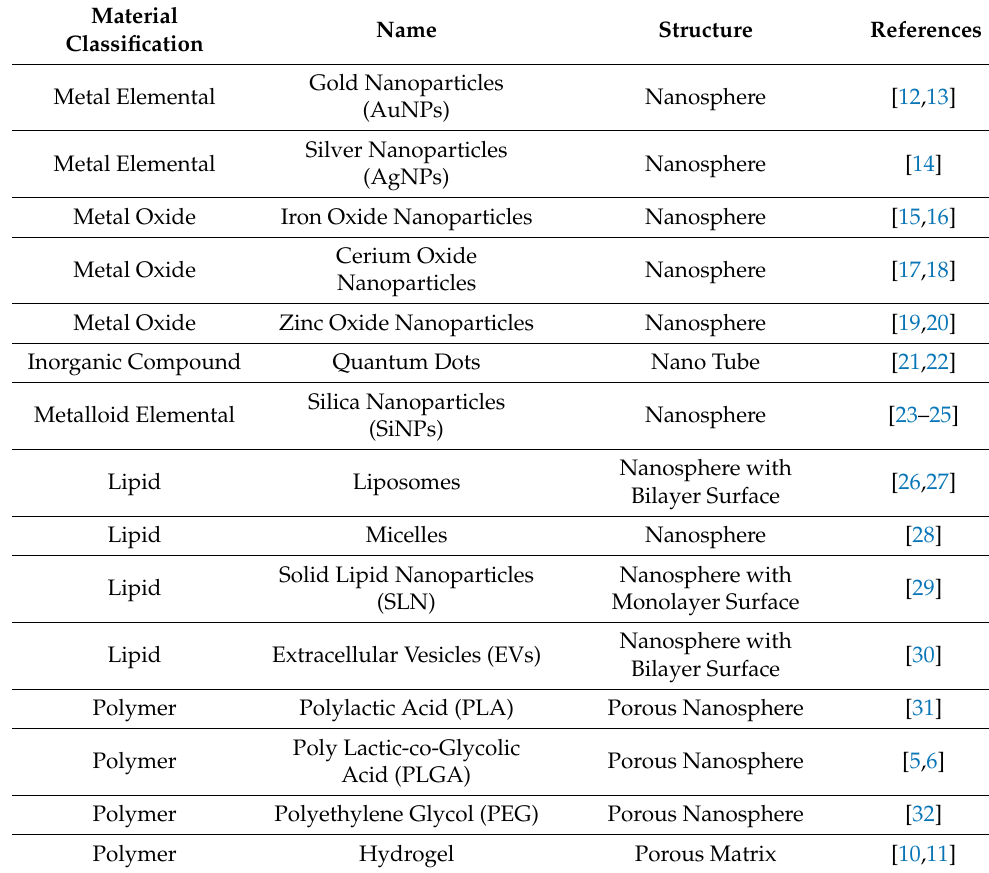
Summary of popular biomaterials used in neurodegenerative diseases and related